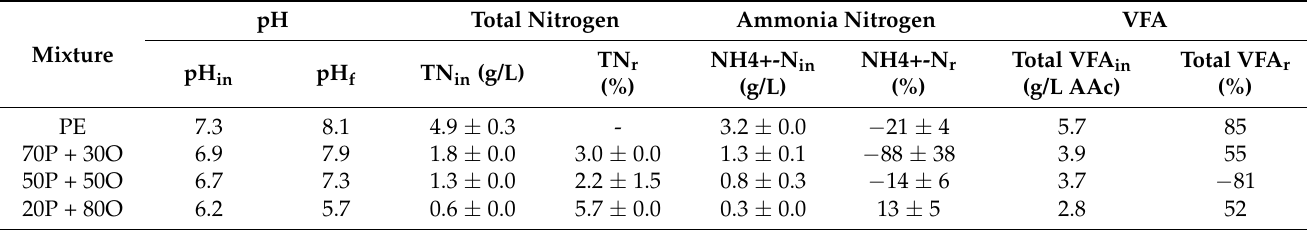
Table 7. Anaerobic digestion of PE + OMW: Total and ammonium nitrogen, pH and VFA.